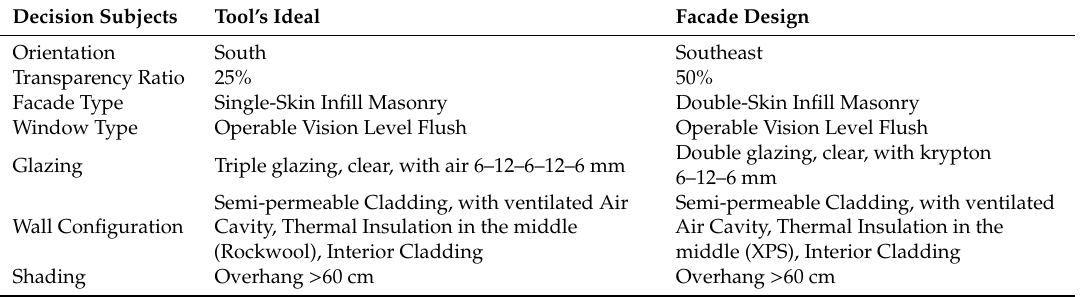
Table 7. Comparison of design decisions for